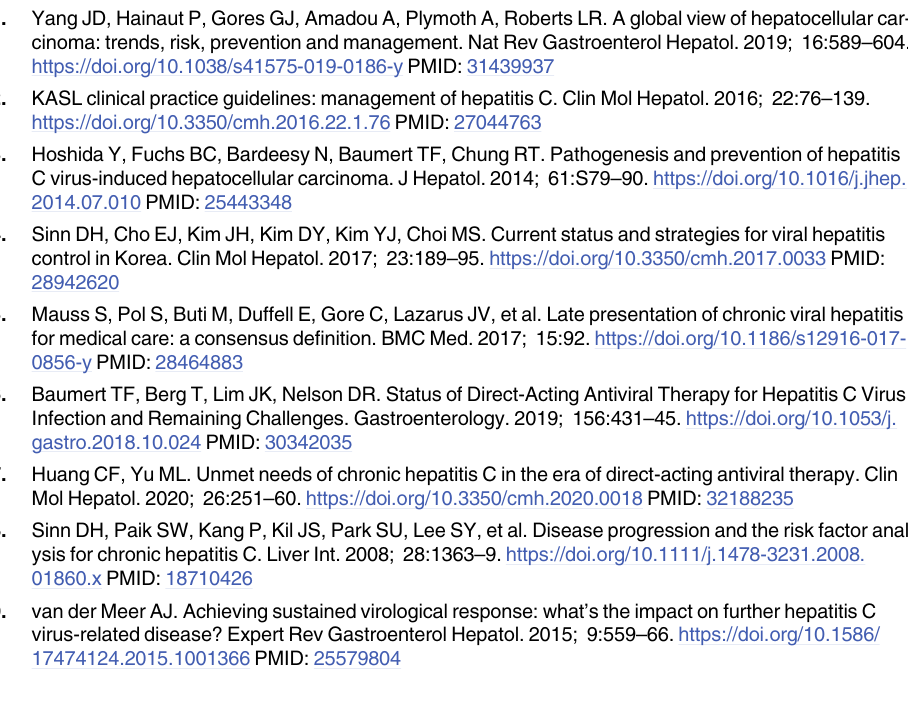
S1 Table. List of therapeutic agents for hepatitis C virus infection. S2 Table. Interval between diagnosis of hepatis C virus infection and hepatocellular carci-